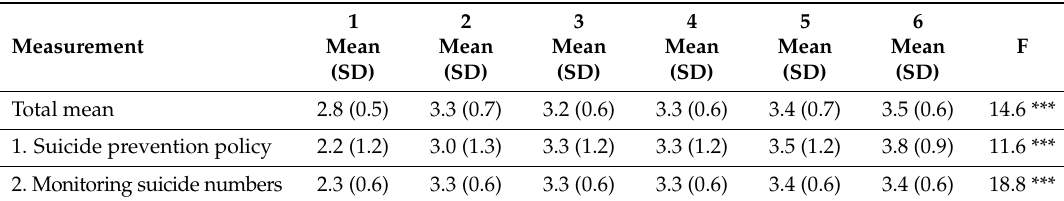
Table 2. Mean rating on the Suicide Prevention Monitor in 24 Mental Healthcare organizations, measurement 1–6 (January 2015–June